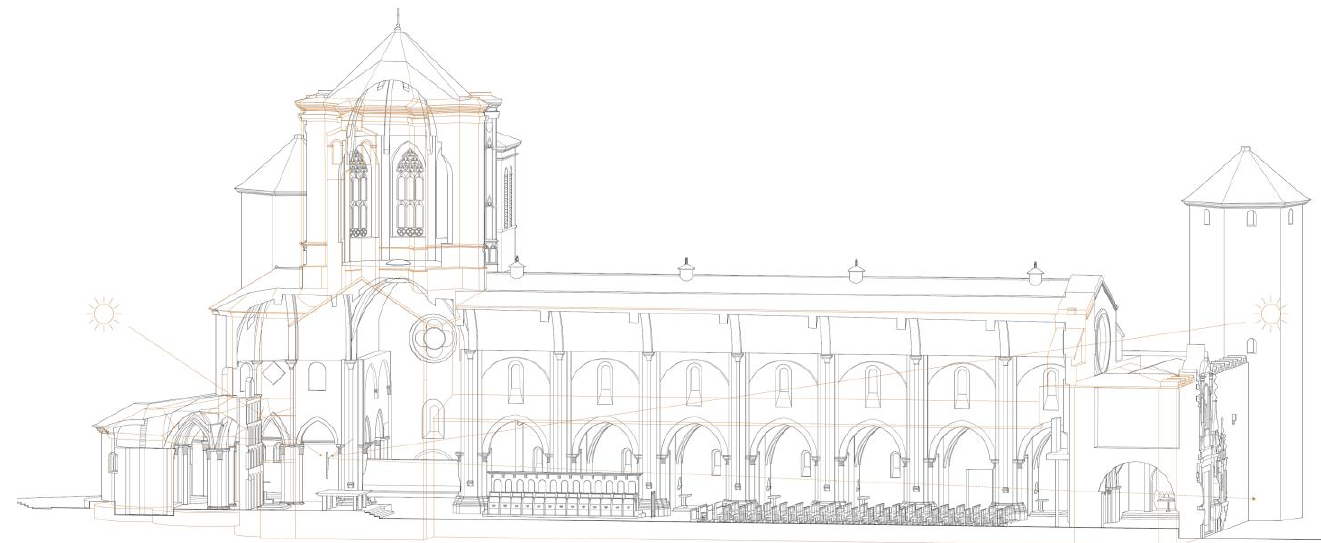
Figure 24. Axonometric section of the Church. Religions 2021 , 12 , x FOR PEER REVIEW